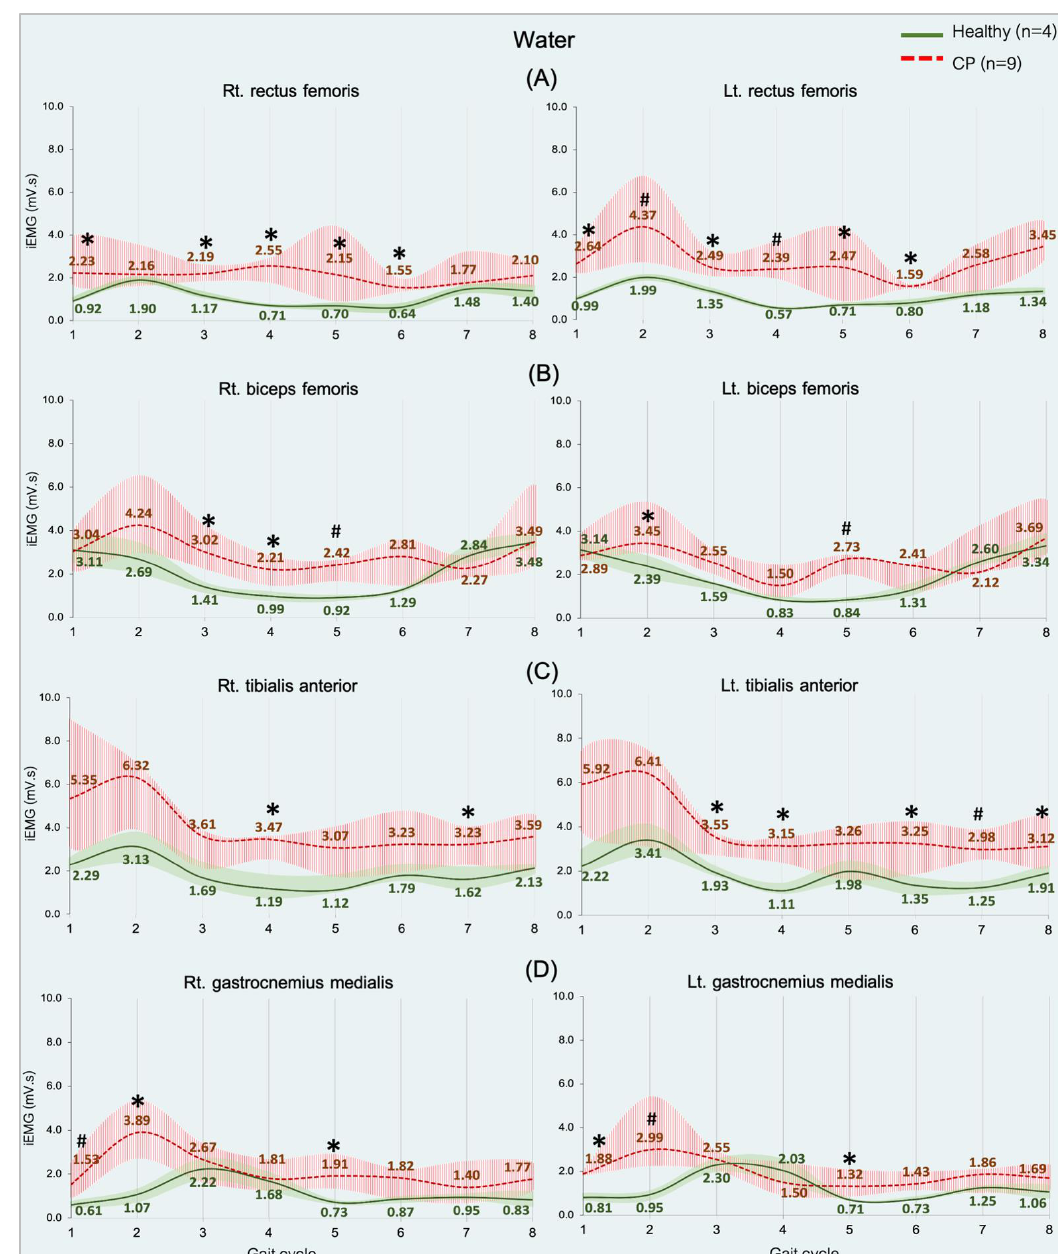
Figure 5. EMG activity during walking in water in the healthy (n = 4) and CP individuals (n = 9). Rectus femoris, RF ( A ), biceps femoris, BF ( B ), tibialis anterior, TA ( C ), and gastrocnemius medialis, GM ( D ). Gait phases: 1 = initial contact, 2 = loading response, 3 = mid stance, 4 = terminal stance, 5 = pre swing, 6 = initial swing, 7 = mid swing, and 8 = terminal swing. * and # are significant median differences between walking on land and in water at p < 0.05 and p <